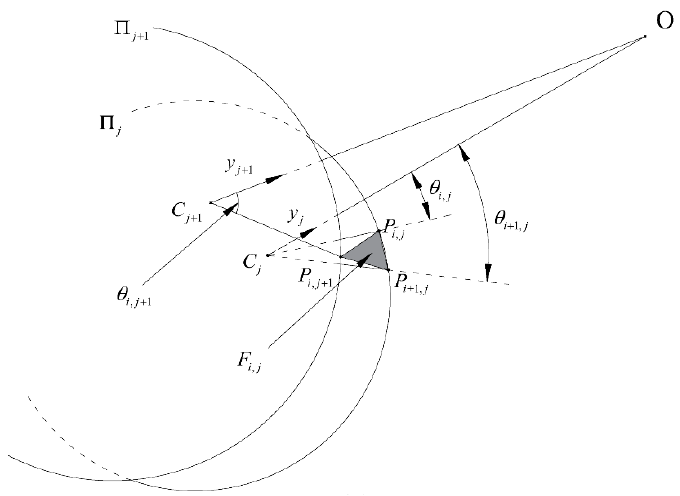
Figure 5. Details of the generation of point P